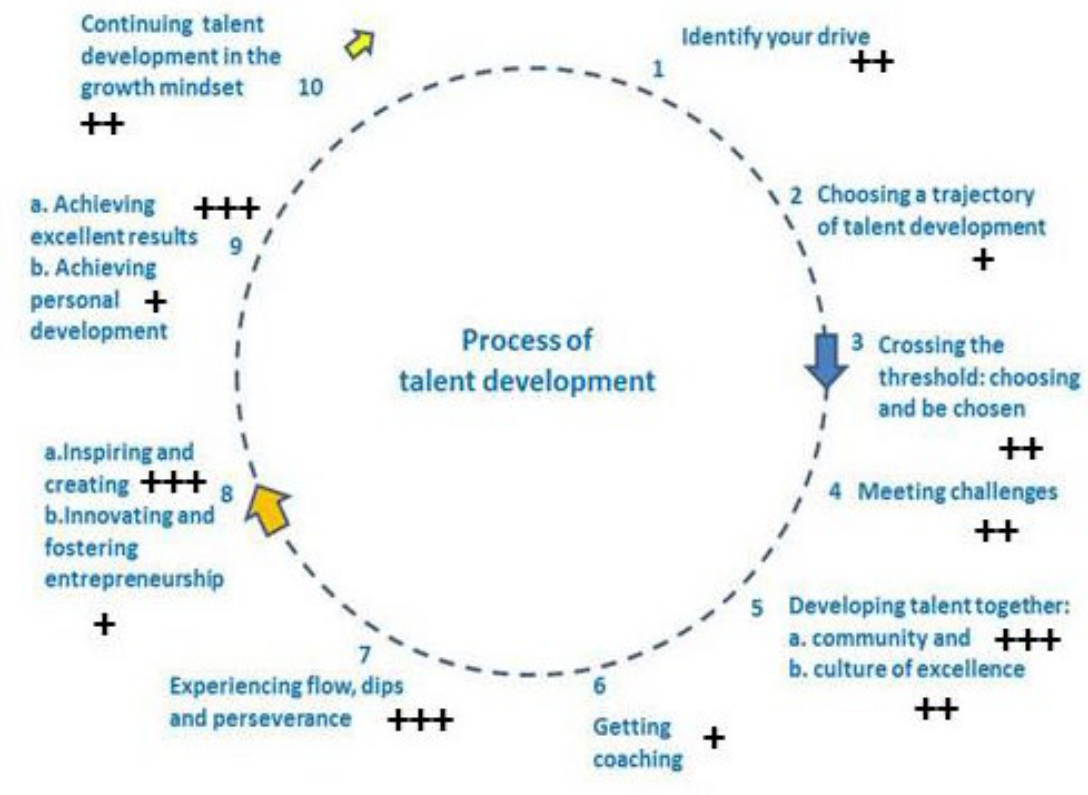
Figure 1: Circle of Talent Development in relation with the good practice ‘International Honors Summer Institute on Holocaust Remembrance’ with the teacher’s